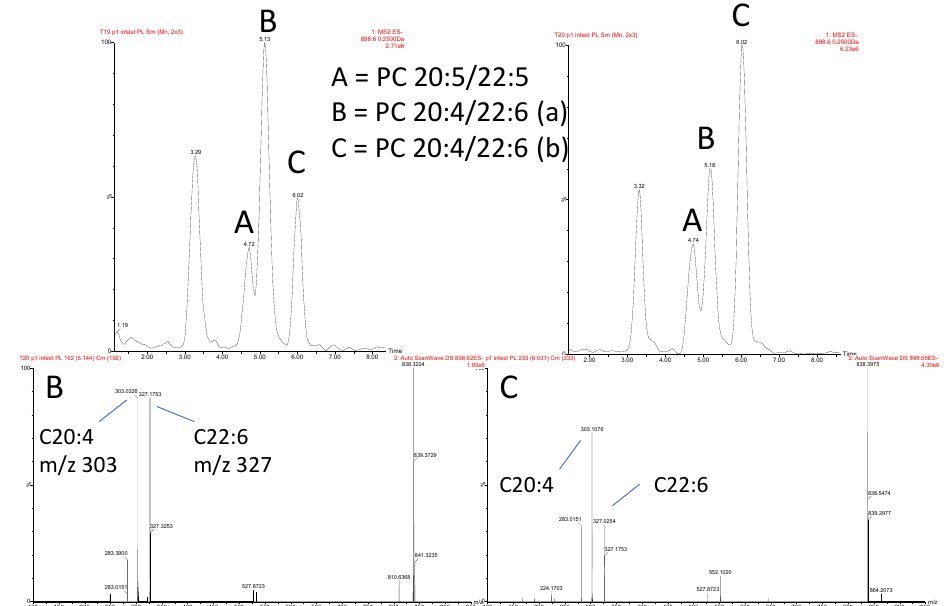
Figure 5. Acyl and putative sn isomer separation based on BEH C18 reverse phase analysis. Putative identification of sn isomers was made based on unit mass and CID fragmentation of precursor ions in negative ion mode. In this example, PC 42:10 is comprised of 3 isomers, with a shift in the relative proportion of the two putative sn isomers in response to diet. (a) and (b) nomenclature is used to designate the putative sn isomers.